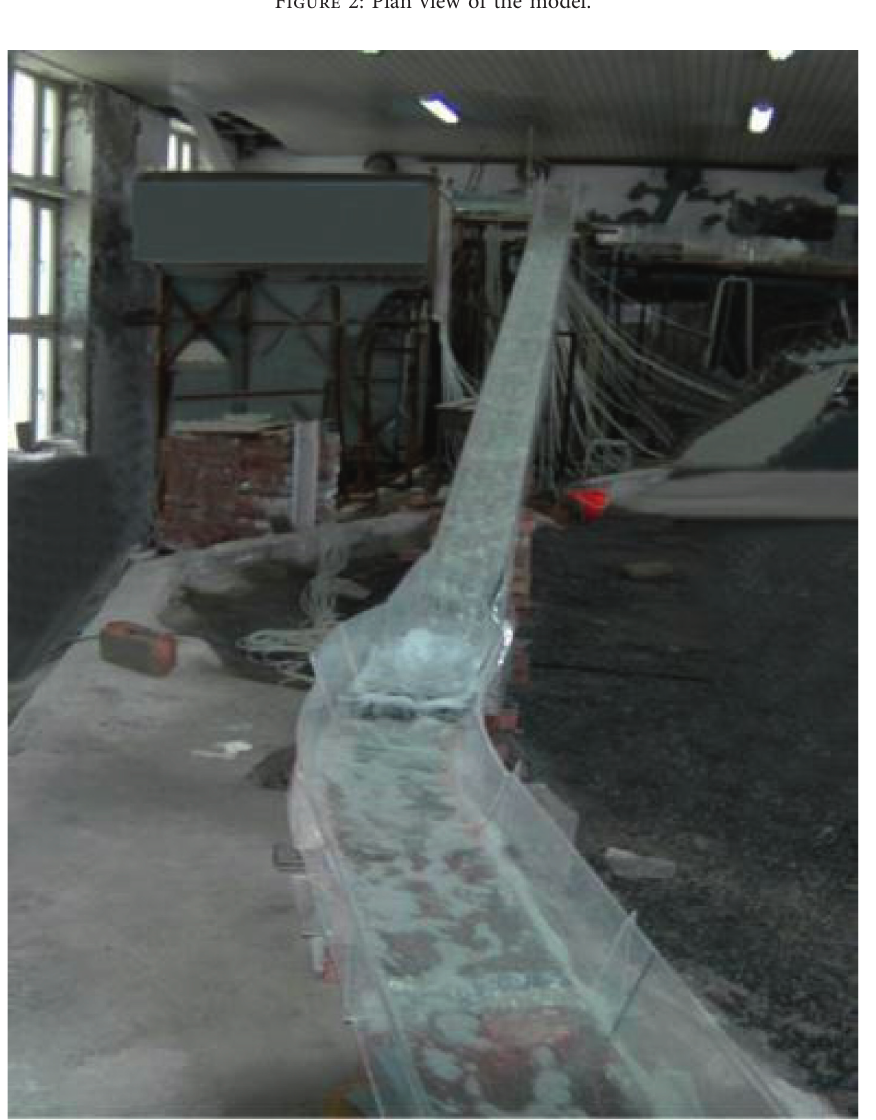
Figure 3: Full view of the model in the